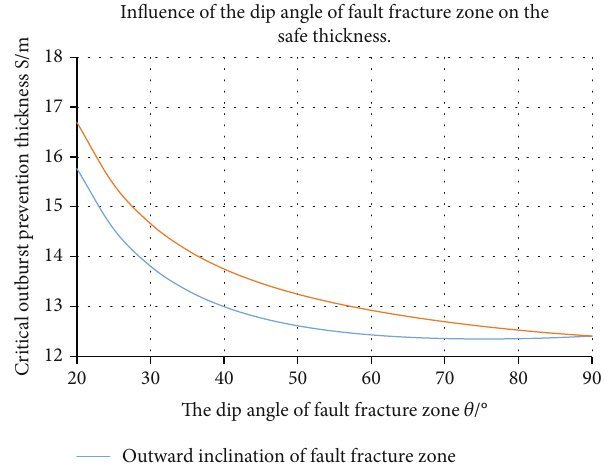
Figure 5: In fl uence of the dip angle of fault fracture zone on the safe